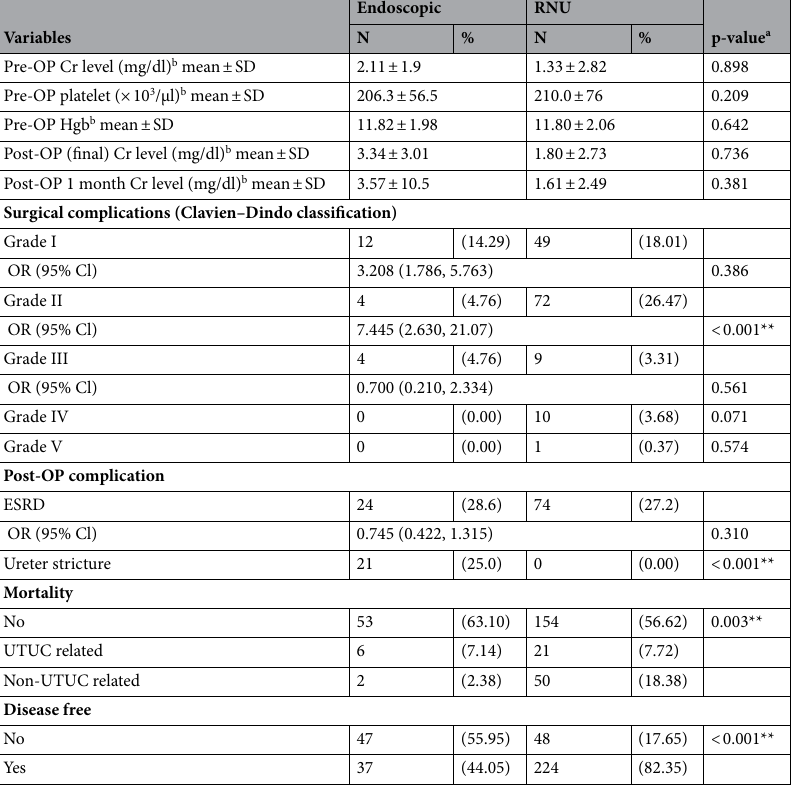
Table 2. Clinical outcome data of endoscopic and nephroureterectomy (RNU) managed UTUC patients. a Chi-Squared test calculated for the difference Variables. b Student’s t-test calculated for the difference in means. *< 0.05. **<